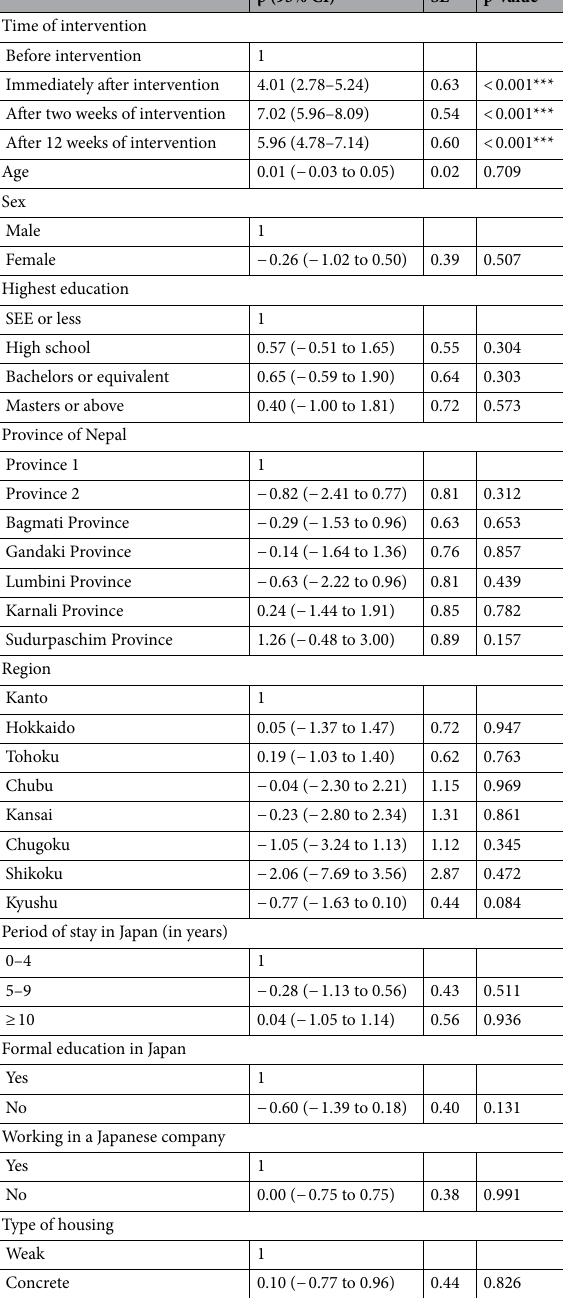
Table 2. Generalized estimating equation model for earthquake preparedness knowledge among Nepalese immigrants residing in Japan (N = 165). SEE Secondary education Examination, SE robust standard error, CI confidence interval. ***p-value <